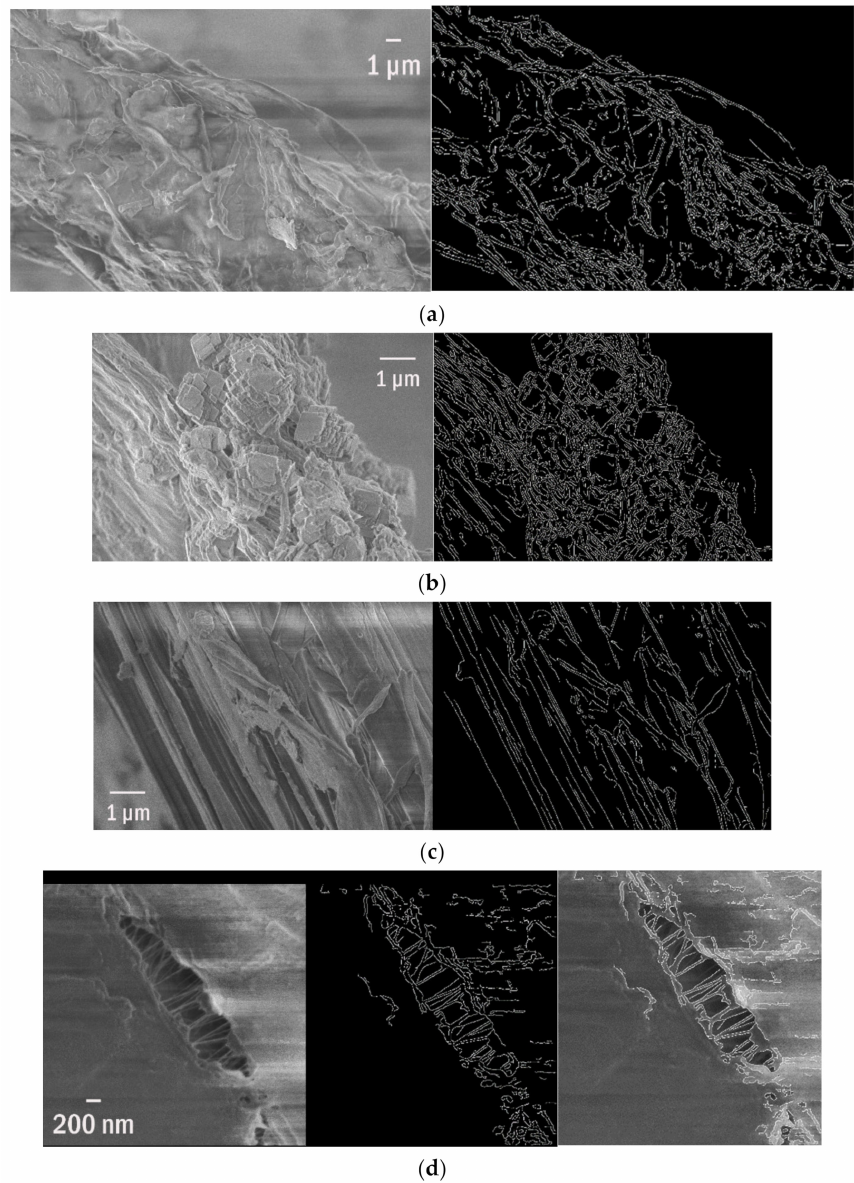
Figure 3. The SEM pictures of ( a – c ) three weathered fibres and ghost nets and their edges, ( d ) edge detection of the